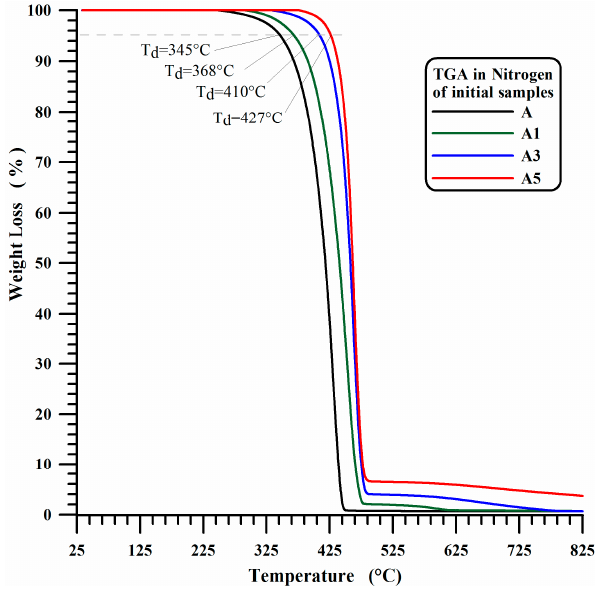
Figure 2. TGA in nitrogen of initial iPP (A) and iPP-MWCNT nanocomposites (A1, A3, A5).